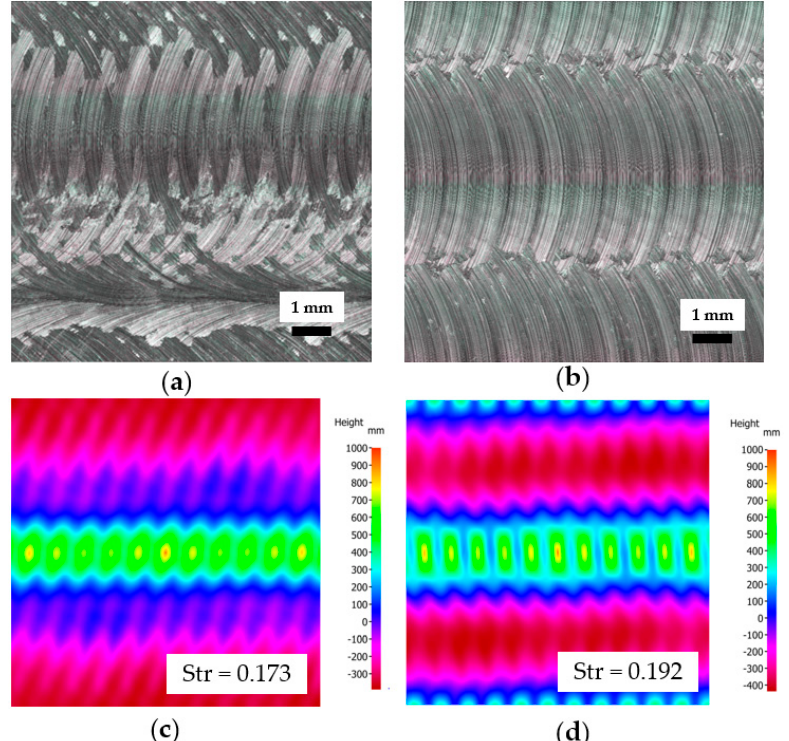
Figure 15. An example of the surface topography of the machined samples ( f z = 0.9 mm, v c = 200 m.min − 1 , a p = 0.2 mm, a e = 6.0 mm, dry cutting): ( a ) Without a tool inclination; ( b ) Tool inclination of 1 ◦ ; ( c , d ) Corresponding autocorrelations and texture aspect ratio values of the surface structures. 3.3. Force Loading Analysis of High Feed Face Milling and Induced Severe Plastic Deformation The parameters of primary shear deformation and its rates were very high, as can be seen in Figure 16. Primary shear deformation decreases with increase of the cutting speed as well as with increase of the feed speed (feed per tooth). ( a )